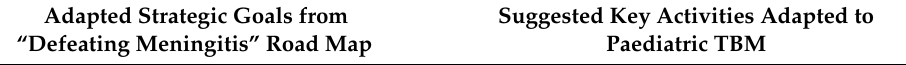
Table 5. Selected relevant strategic goals reproduced from Pillar 4 the “defeating meningitis” roadmap and suggested paediatric TBM-related activities